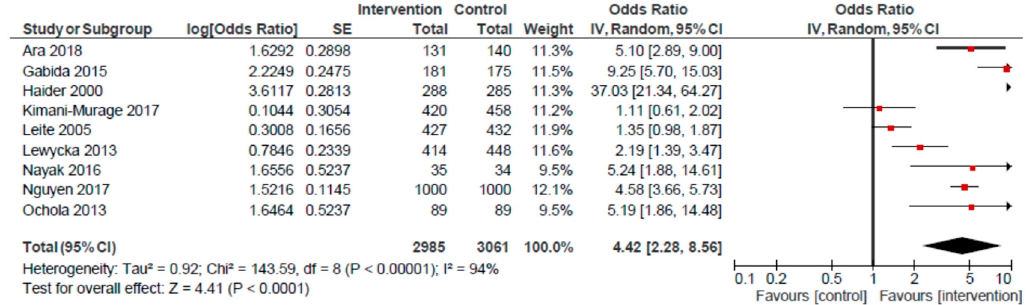
Figure3. Forestplotofthemeta-analysisofexclusivebreastfeedingforhomevisits(randomizedstudies). Figure 2. Forest plot of the meta-analysis of exclusive breastfeeding for home visits (randomized studies).